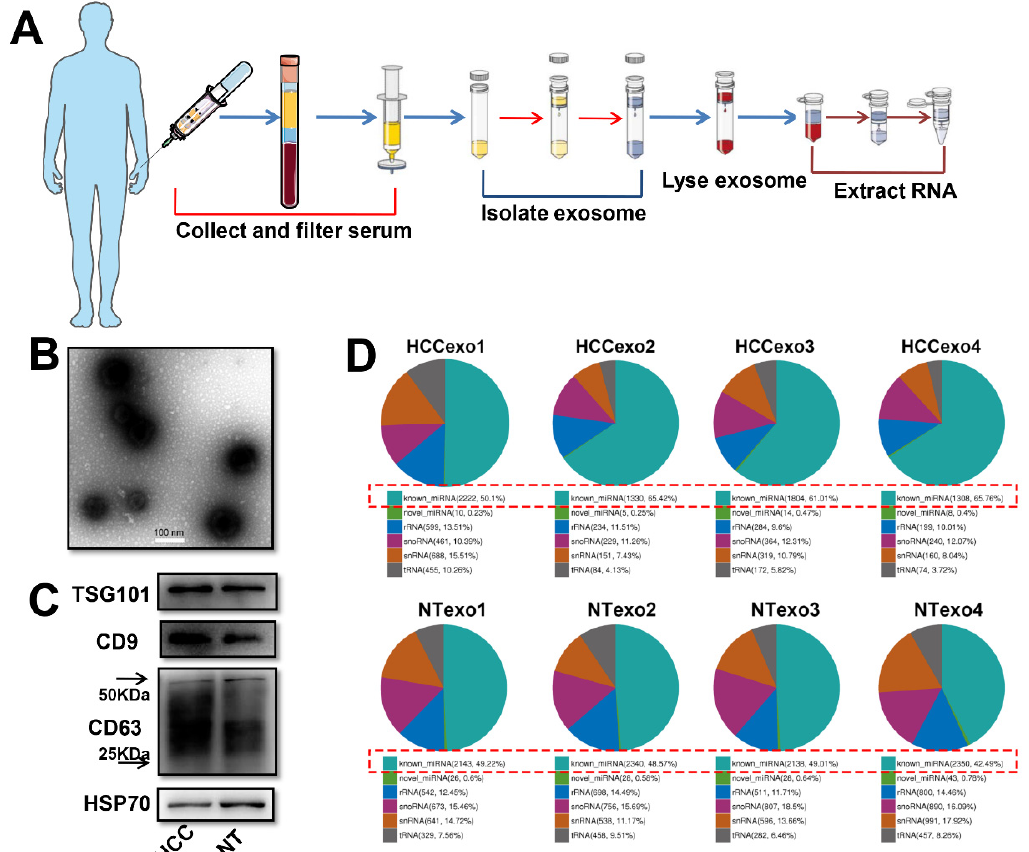
Figure 1. Profiling and analyzing the exosome-derived small RNAs in the serum of HCC patients and non-tumor donors. ( A ): The schematic diagrams illustrate the procedure of exosome-derived small RNAs’ collection from HCC patients. ( B ): The transmission electron micrograph depicts the serum exosomes isolated from HCC patients. ( C ): Four typical exosome markers are detected from proteins extracted from isolated exosomes by Western blot. ( D ): The proportions of various types of small RNAs in serum exosomes from HCC patients and non-tumor